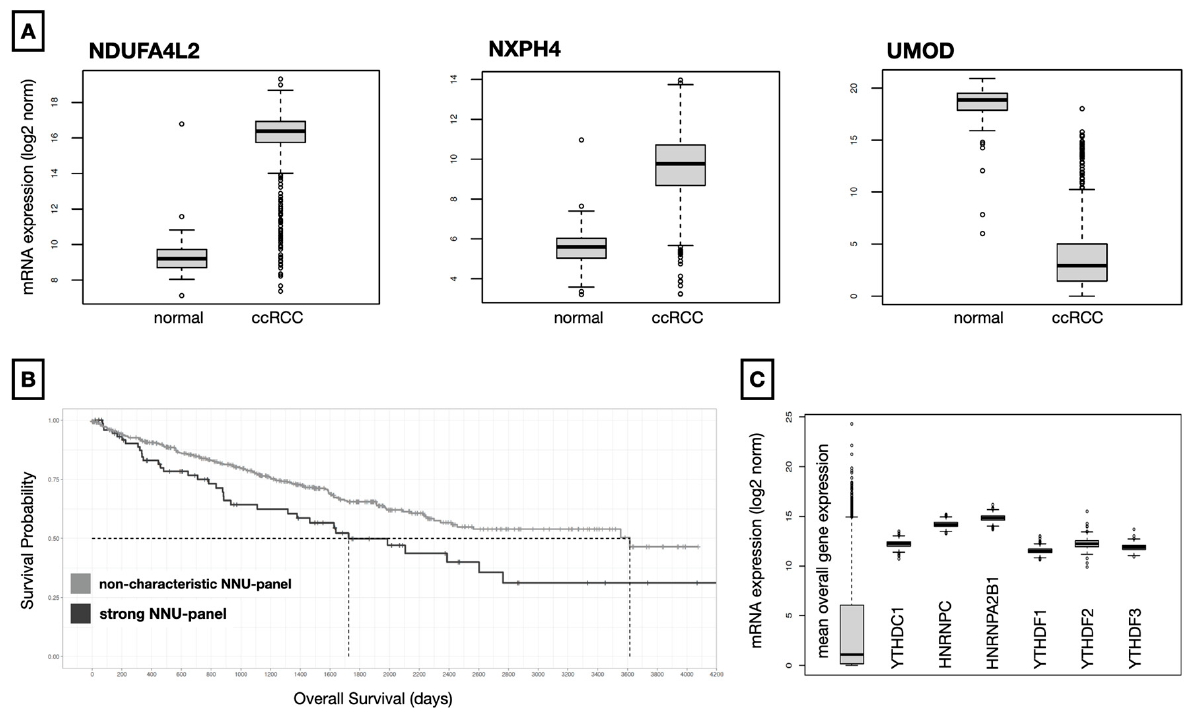
Figure 2. Expression analysis of the TCGA-KIRC cohort. ( A ) Boxplots of the NNU panel expression differences between clear cell renal cell carcinoma (ccRCC) and normal renal tissue. NDUFA4L2 (fc 55.55; adjusted p -value < 0.0001) and NXPH4 (fc 23.17; adjusted p -value < 0.0001) showed significant upregulation. A significant downregulation was observed for UMOD (fc 0.0028; adjusted p -value < 0.001). ( B ) Kaplan–Meier plot visualising the impact of a characteristic m6A-driven NNU panel on overall survival. Affected patients had a significantly poorer outcome ( p = 0.0075, log-rank). ( C ) Expression profiles of the major m6A readers in ccRCC. YTHDC1, HNRNPC, HNRNPA2B1, and YTHDF1-3 were all strongly expressed in ccRCC compared to the mean overall gene expression of the cancerous